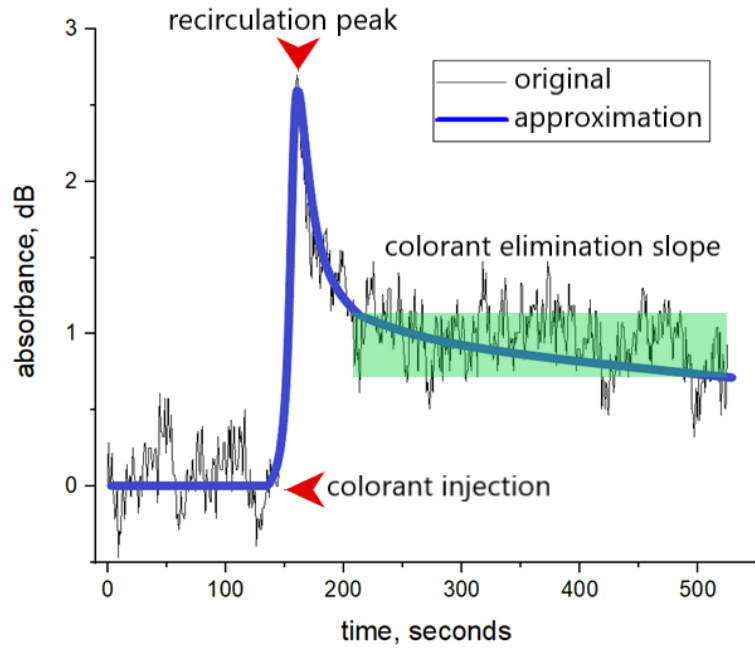
Figure 8. Example of a signal obtained during clearance test and its